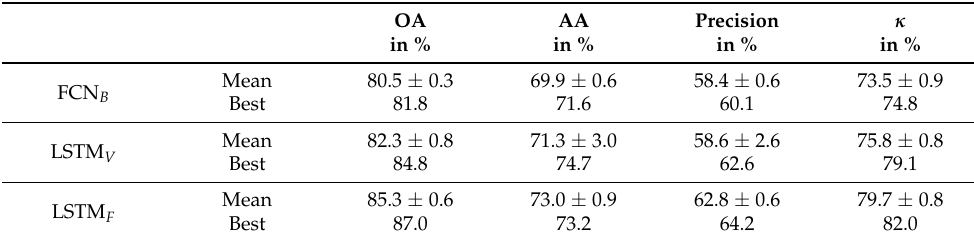
Table 3. Scores of all models. Average accuracy (AA) and precision are unweighted averages of the class-wise scores. Mean denotes the average plus the standard deviation across the five models; Best denotes the score of the best ensemble.